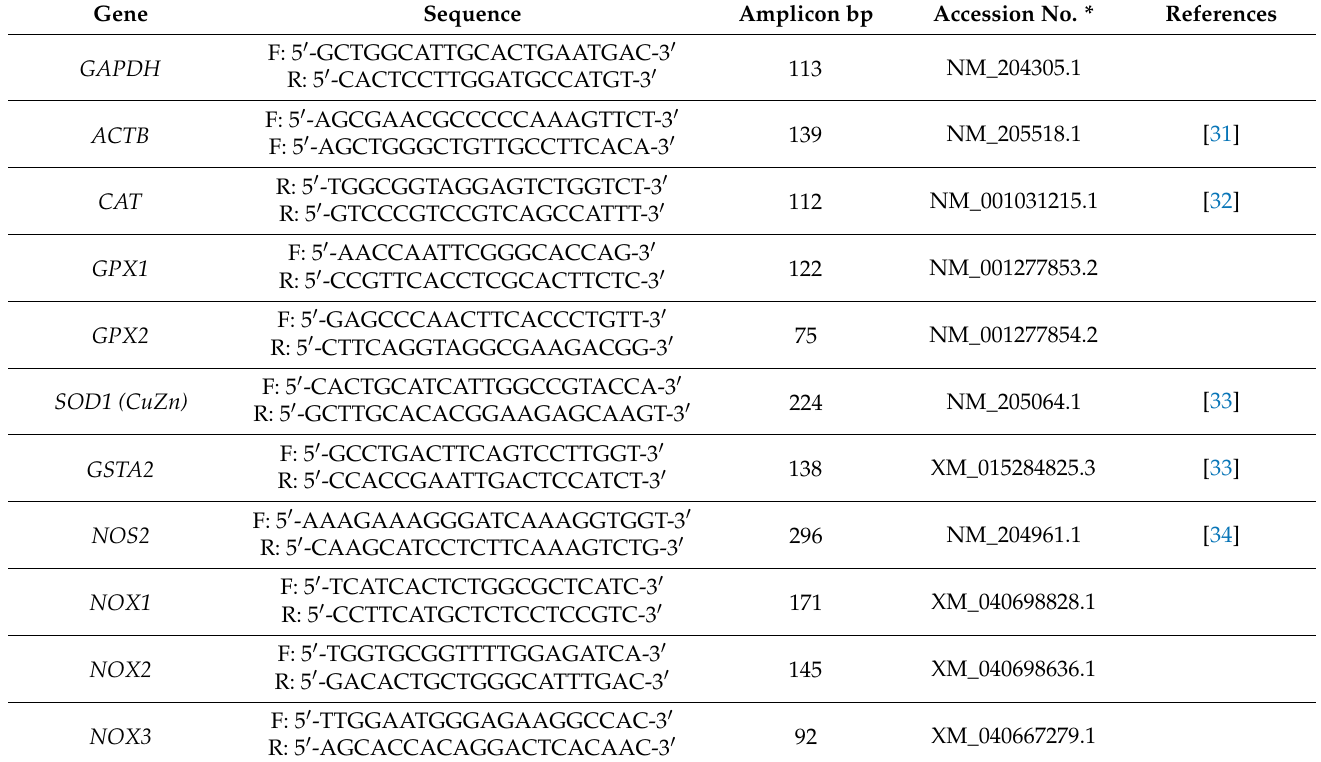
Table 3. Sequences and relative positions of primers for target genes used in real-time qPCR. Gene Sequence Amplicon bp Accession No.